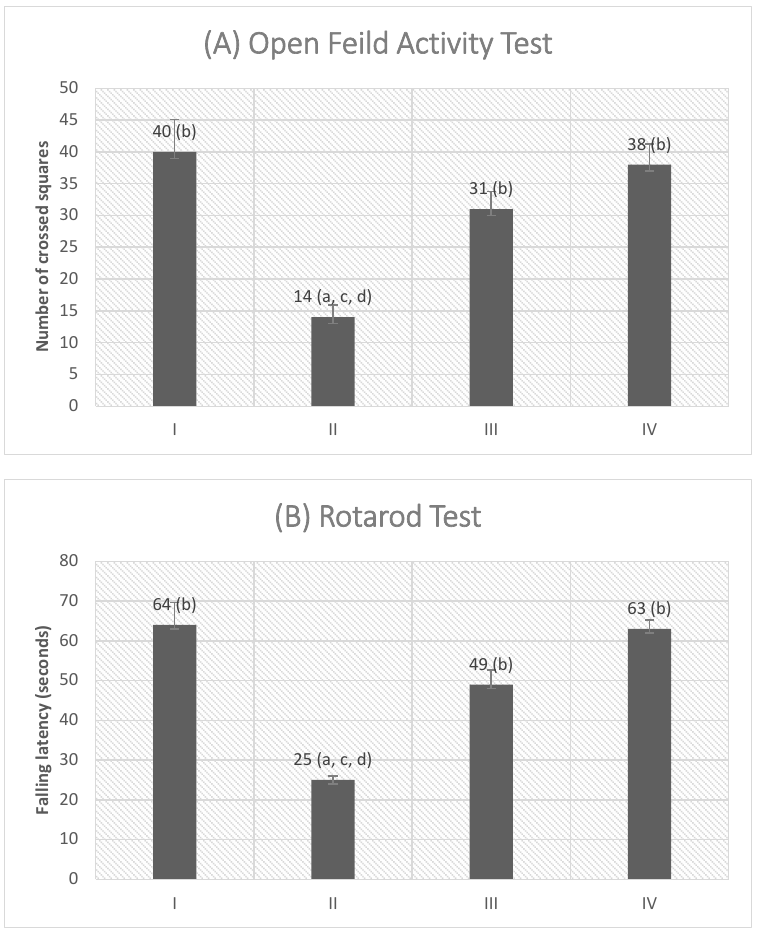
Figure 8. Effects of empagliflozin treatment on the motor behavioral deficit of vigabatrin-treated rats. Locomotor activity ( A ) is presented as the number of crossed squares in the open field arena. Motor coordination ( B ) is presented as falling latency on the rotarod apparatus (seconds). Values are represented as mean ± SD (n = 10). a denotes a statistically significant difference compared to group I; b denotes a statistically significant difference compared to group II; c denotes a statistically significant difference compared to group III; d denotes a statistically significant difference compared to group IV, by one-way analysis of variance followed by post hoc Tukey’s test.